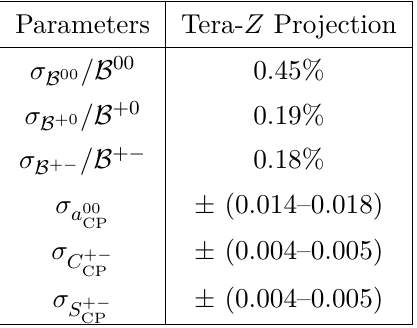
Table 8 . Statistical uncertainties for relevant input parameters used to determine α at Tera- Z . The ranges of estimation correspond to (cid:15) [15 , 25]% eff ∈